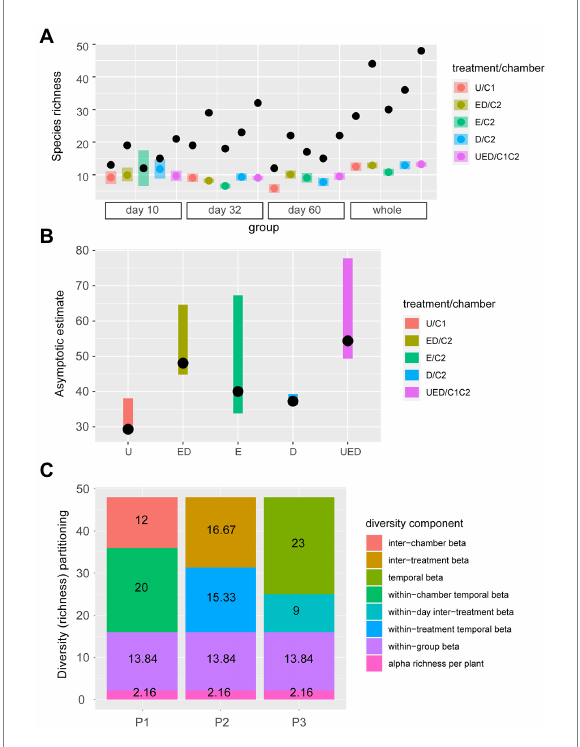
FIGURE 3 Variation in species richness. (A) Species richness standardized by coverage (68%) depending on the plant initial conditions (treatments: undamaged (U), damaged (D), or exposed (E) and chamber C1 and C2 (ED), sampling day (10, 32, or 60), or combined (UED). The black points, colored points, and bars represent the observed richness, the average of the estimated richness, and 95% confidence intervals of the estimate, respectively. The results were grouped into each sampling day (day 10, day 32, and day 60), and the whole period (whole). (B) Asymptotic estimate of species richness. The points and bars represent the point estimate of asymptotic richness and its 95% confidence intervals. (C) Partitioning of γ species diversity. For all three partitioning methods (P1, P2, and P3), the α diversity (average richness per individual per sampling day) and within- group β diversity (variations within 16 replicates per treatment per sampling day) were common. The calculations are presented in Supplementary Appendix S1; Supplementary Figure S5; and Supplementary Table S2 in the Supplementary